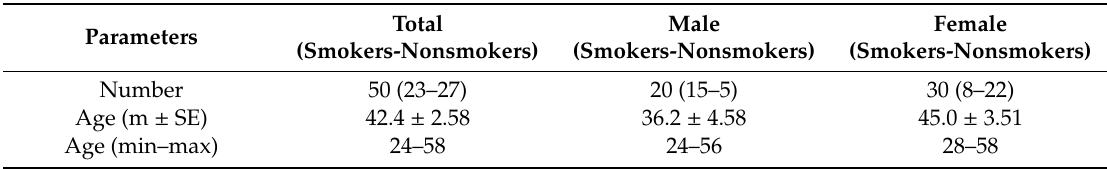
Table 1. Gender and age characteristics of observed